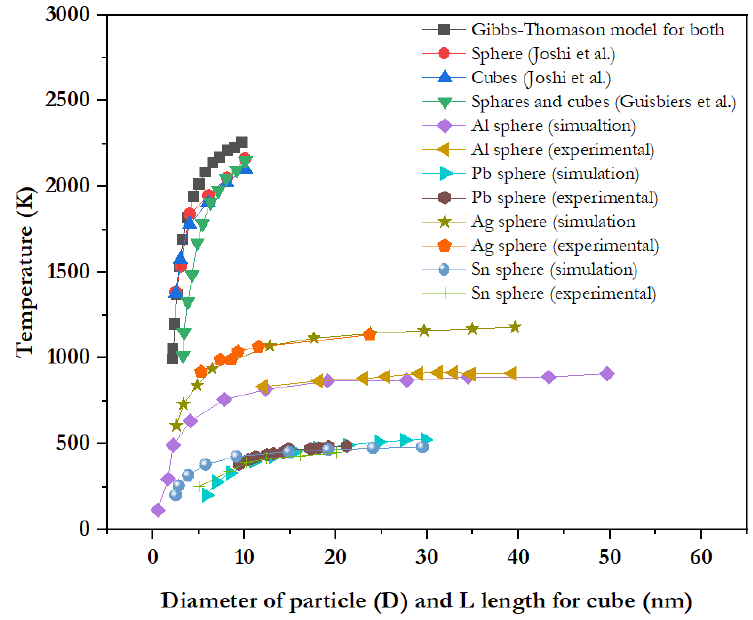
Figure 1. Variation of melting temperature with particle diameter for spheres and a length cubes, for Gibbs-Thomsan model for spheres and cubes [12], for red spheres [12], for blue cubes [12], for Al, Pb, Ag and Sn [7].